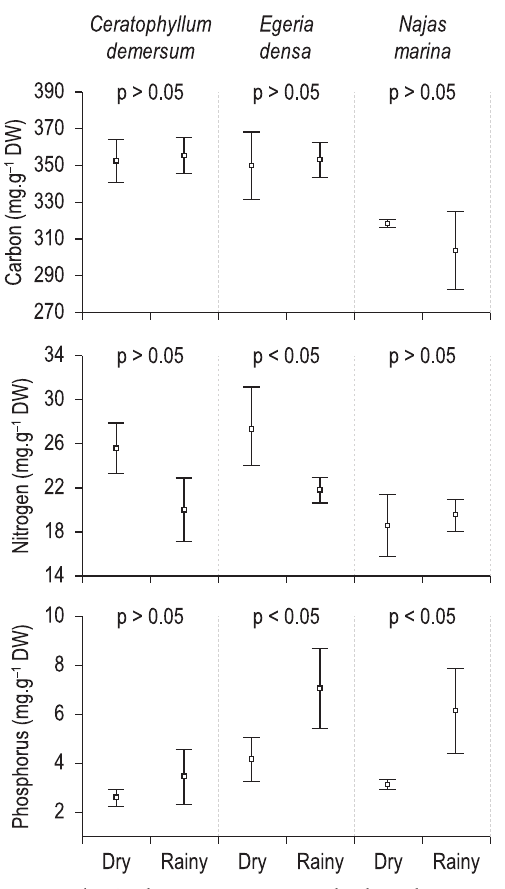
Figure 4. Carbon, nitrogen and phosphorus in Ceratophyllum dermesum , Egeria densa and Najas ma- rina in Campelo Lagoon in dry (July/2001) and rainy (January/2002) season. The vertical bars represent the standard deviation; p: significance level.